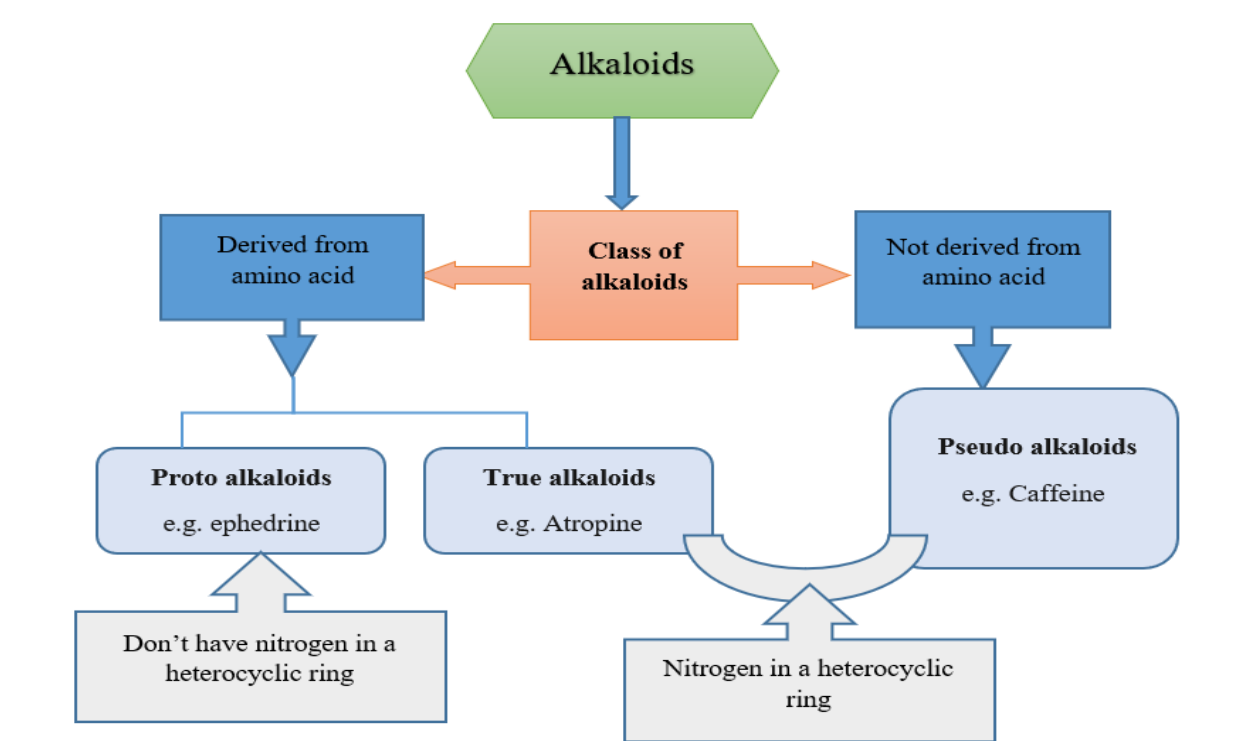
Figure 2. Classification of alkaloids based on chemical structures